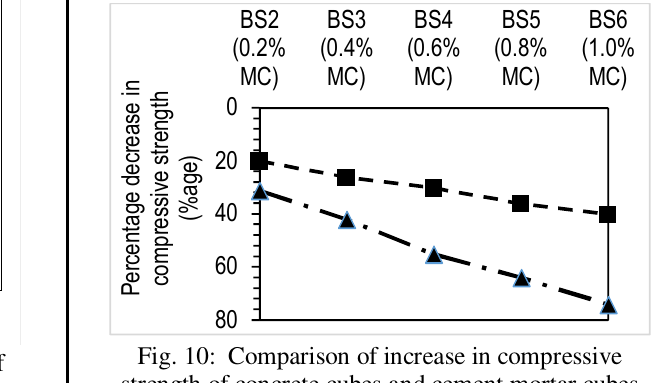
Fig. 9: Relationship of MC content and the ratio of cube to cylinder compressive strength